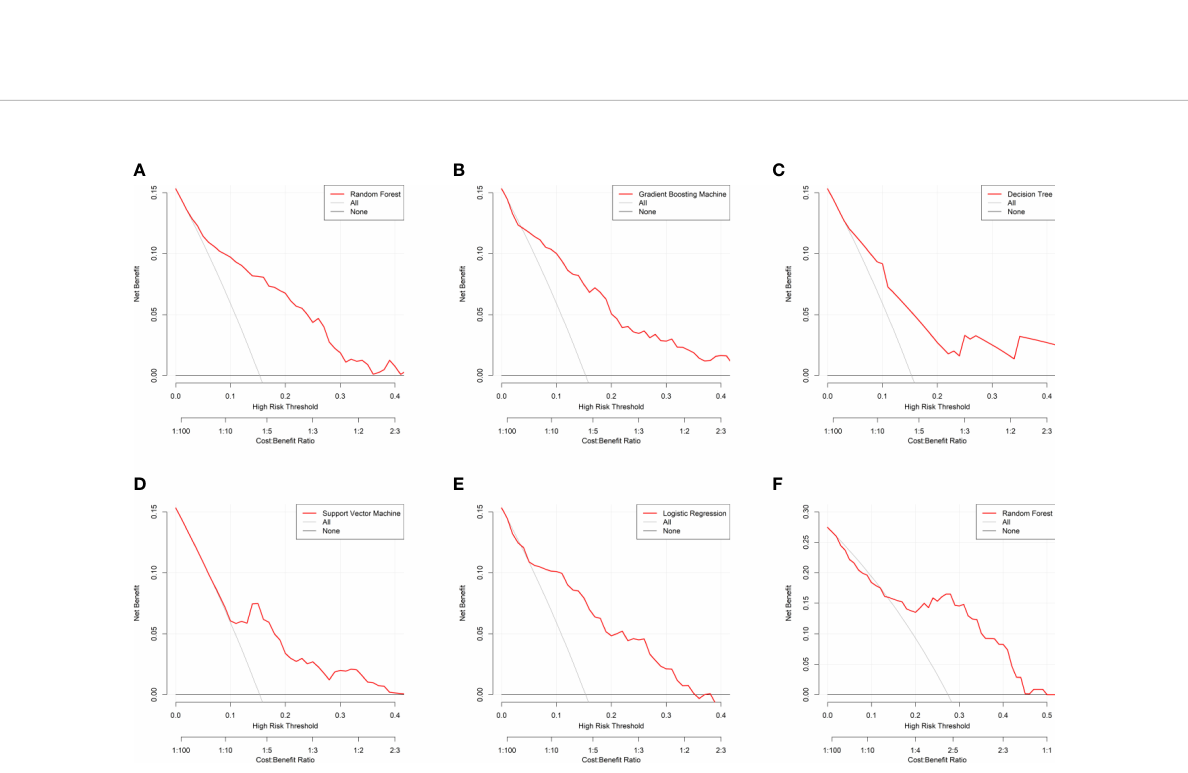
FIGURE 6 Decision curve analysis for the machine learning-based models. (A) Random Forest for internal validation; (B) Gradient Boosting Machine; (C) Decision Tree; (D) Support Vector Machine; (E) Logistic Regression; (F) Random Forest for external validation. The horizontal black line is treated-for-none scheme, and the solid gray line is treated-for-all